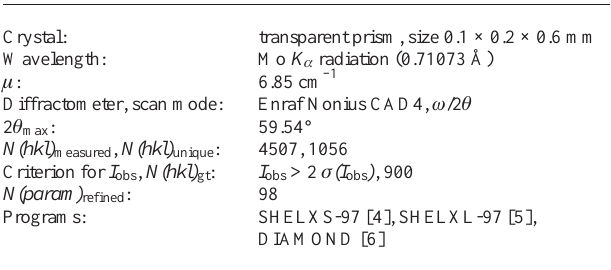
Table 1. Data collection and handling.